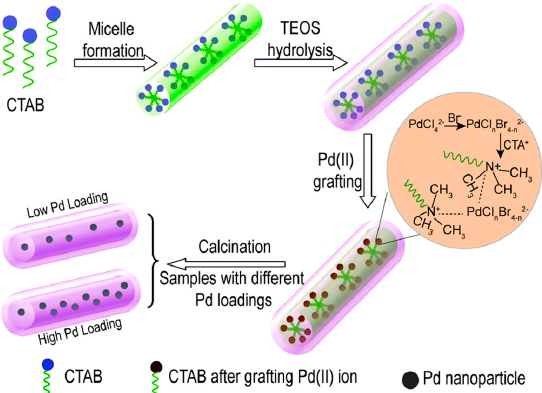
Figure 45. One-pot synthesis route for Pd/MCM-41. Reproduced with permission from [88]. Copyright 2015 Royal Society of Chemistry .